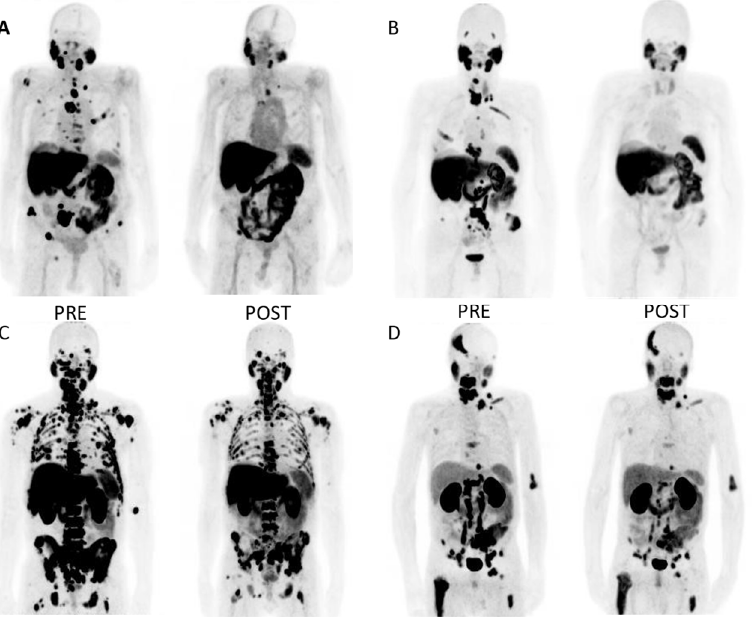
Figure 2. Example PSMA PET image pairs ( A – D ) in four mCRPC patients before and after PSMA- RLT. ( A ): Patient with bone metastases only. Pre-treatment PSA was 83.6 ng/L. He received seven cycles of 177 Lu-PSMA-617, which resulted in a significant response. PSA after the treatments was 3.2 ng/L. PFS(PSA) was 23.5 months (mo) and OS was 2.4 y. ( B ): Patient with metastases mostly in bones